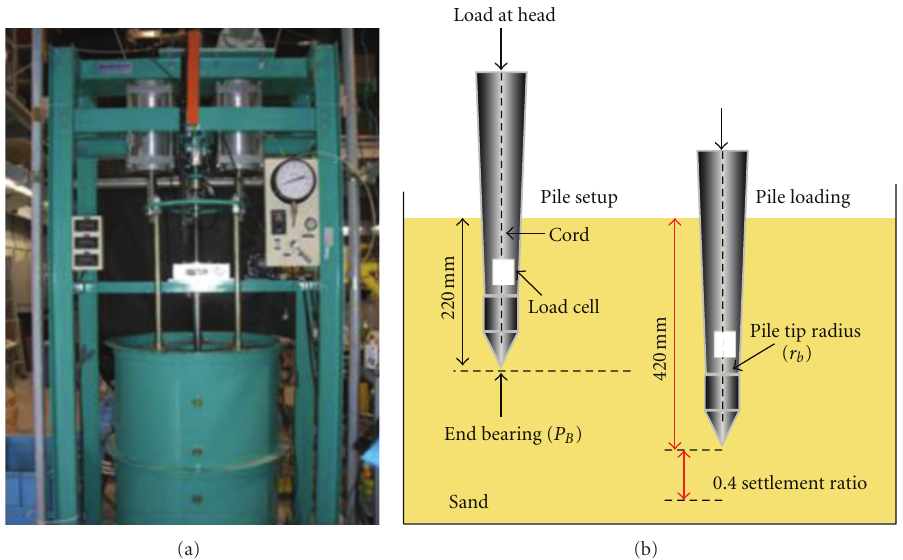
Figure 1: (a) Pile load chamber and (b) cast-in-place pile set up and loading mechanism (figure not to scale).